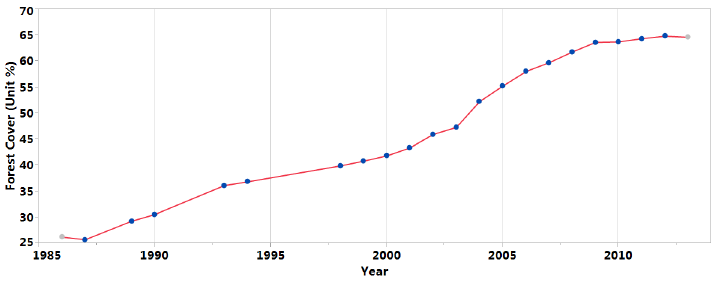
Figure 7. Annual forest cover condition and dynamic for plantation area. The dynamics of forest cover over time resembles a logistic ( S -shaped) growth curve, which